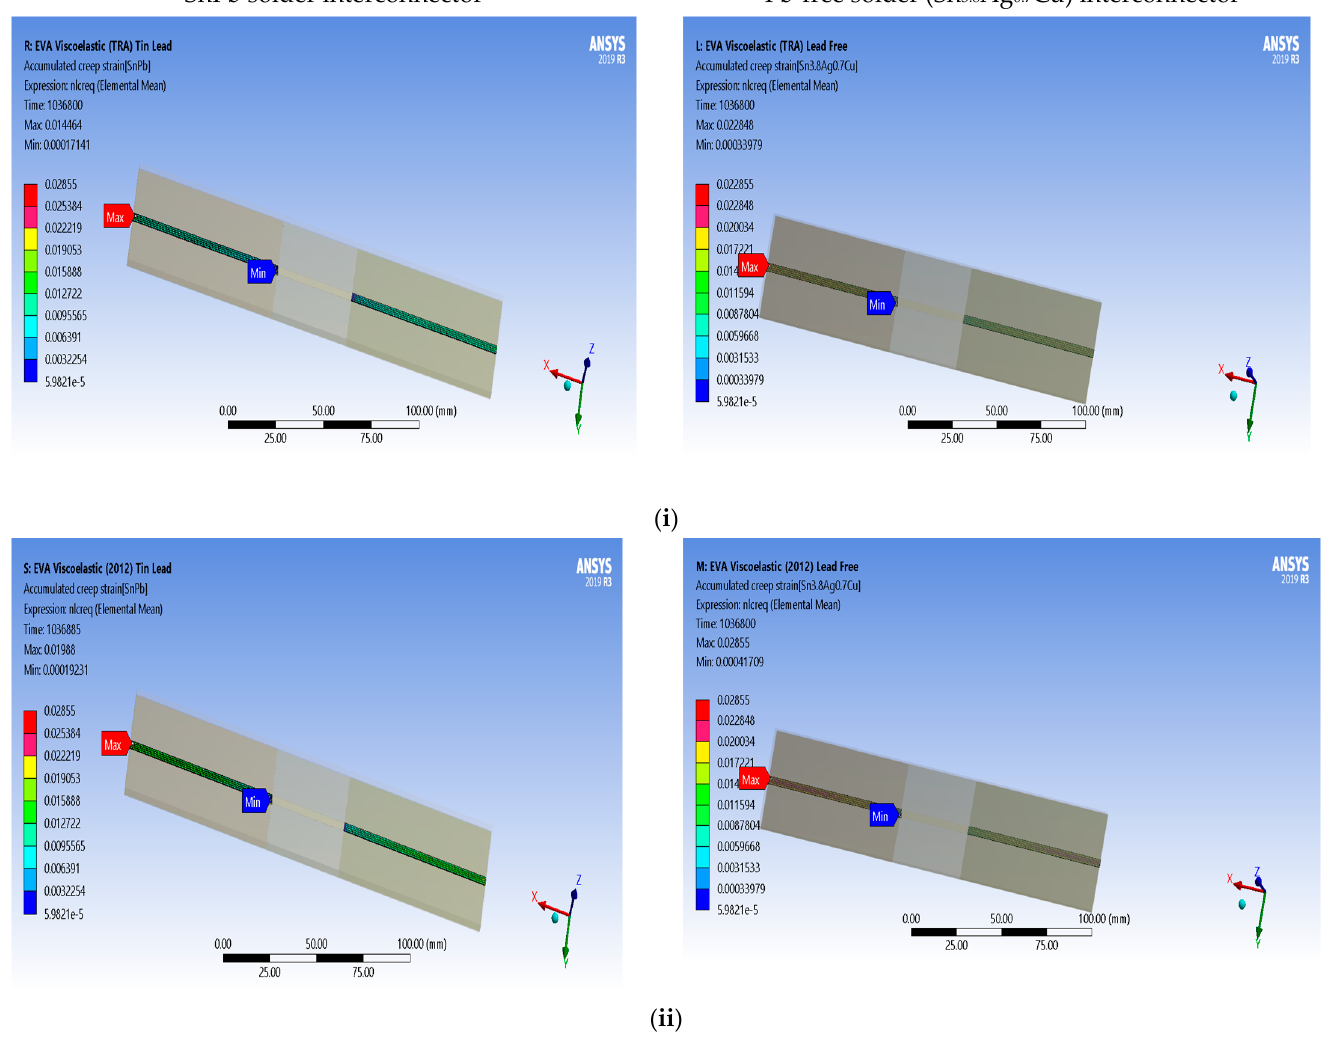
Figure 10. Accumulated creep strain damage distribution in PbSn and Pb-free solder interconnection for: ( i ) TRA and ( ii ) 2012 thermal cycles.